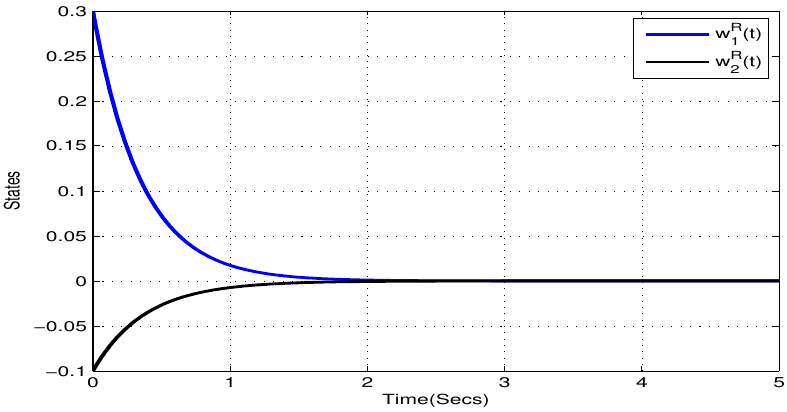
( t ) , w R ( t ) of systems (22) in Example 1. 2 1